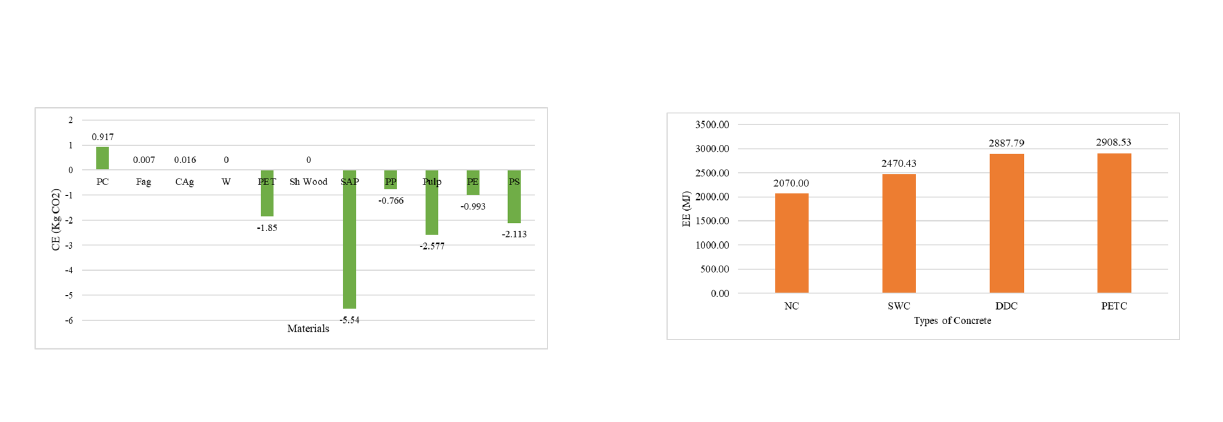
Fig. 5. EC Value of Concrete Materials (Rp/kg)